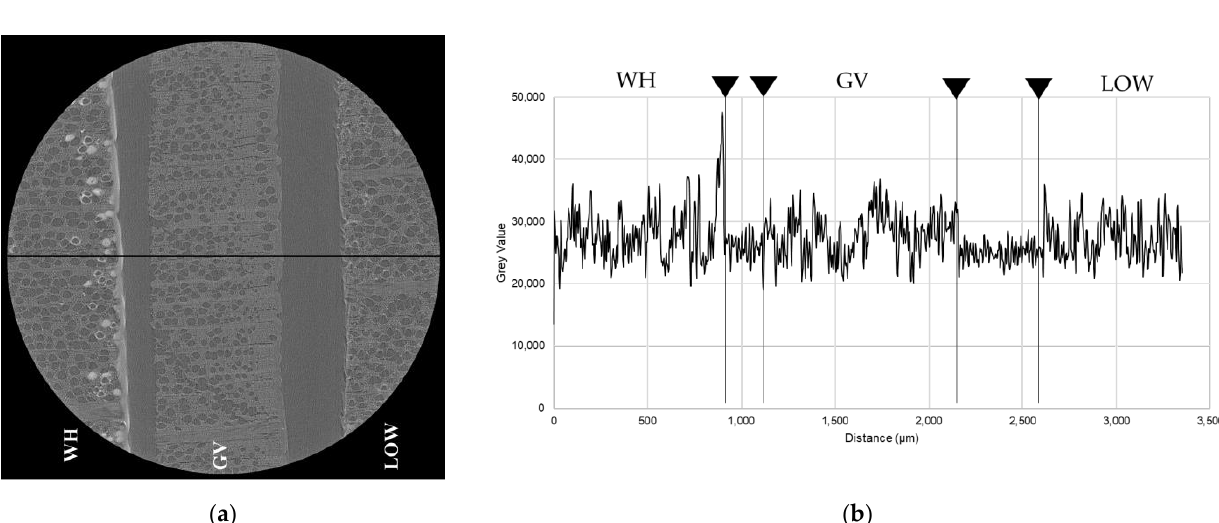
Figure 11. Sample series 2 Mo target with Al filter down side (WH, GV, LOW); ( a ) visualization result and the plot profile line; ( b ) plot profile graphic.